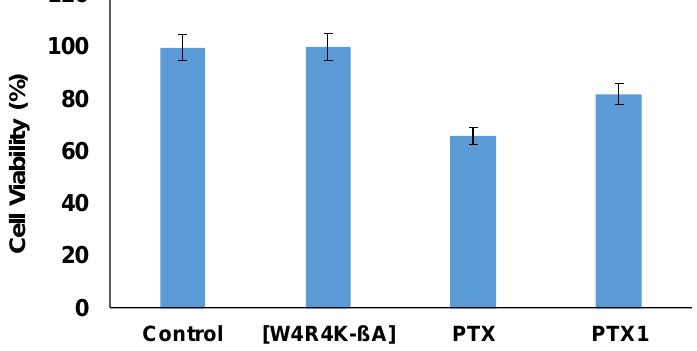
Figure 2. The antiproliferative activity of PTX and PTX1 at (5 µM) concentration in HEK-298 cell line after 72 h incubation.